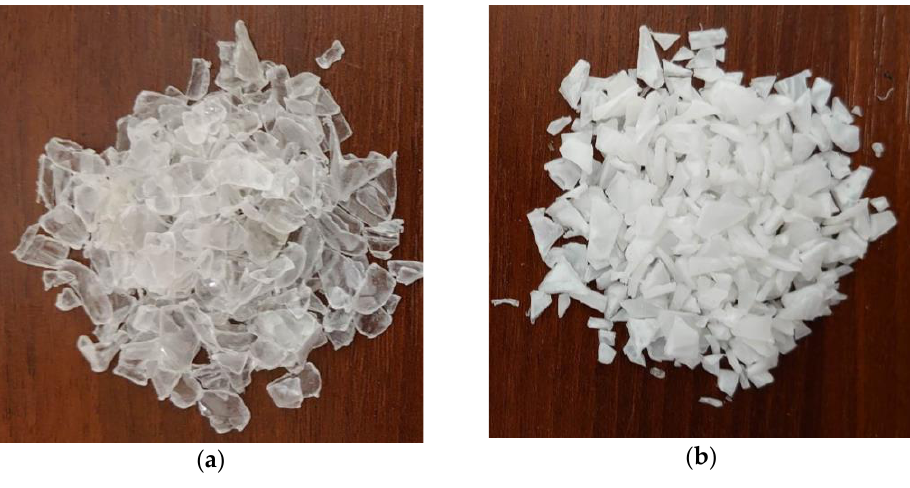
Figure 1. Samples of used plastomers: ( a ) PET ( b ) PP.